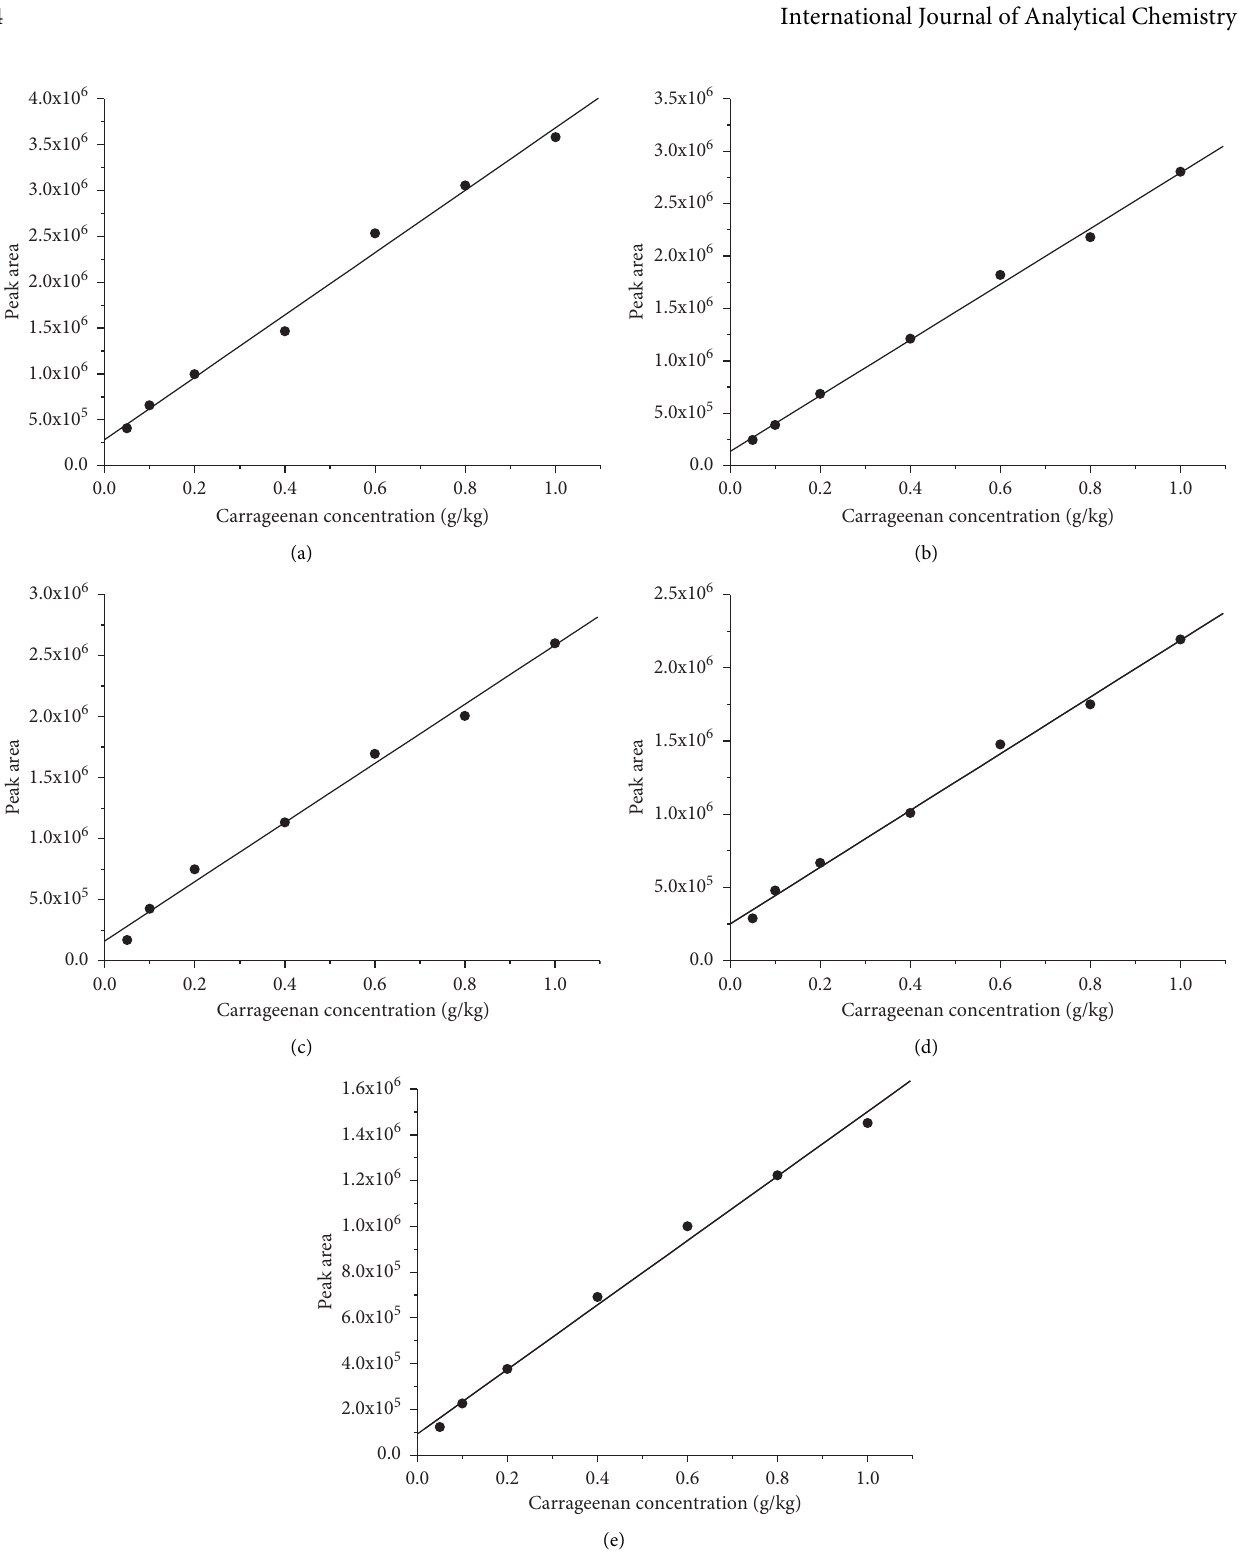
Figure 2: The standard curves based on the UHPLC-MS/MS method for detecting the carrageenan in five different types of livestock and poultry meat (the concentration gradient of carrageenan solution is 0.05, 0.10, 0.20, 0.40, 0.60, 0.80, and 1.00g/kg, a total of seven concentration points). The x -axis is the mass concentration of carrageenan; the y -axis is the peak area of the carrageenan standard solution at each concentration. The standard curve of carrageenan in (a) pork matrix, (b) beef matrix, (c) lamb matrix, (d) chicken matrix, and (e) duck matrix. UHPLC-MS/MS, ultrahigh-performance liquid chromatography-tandem mass